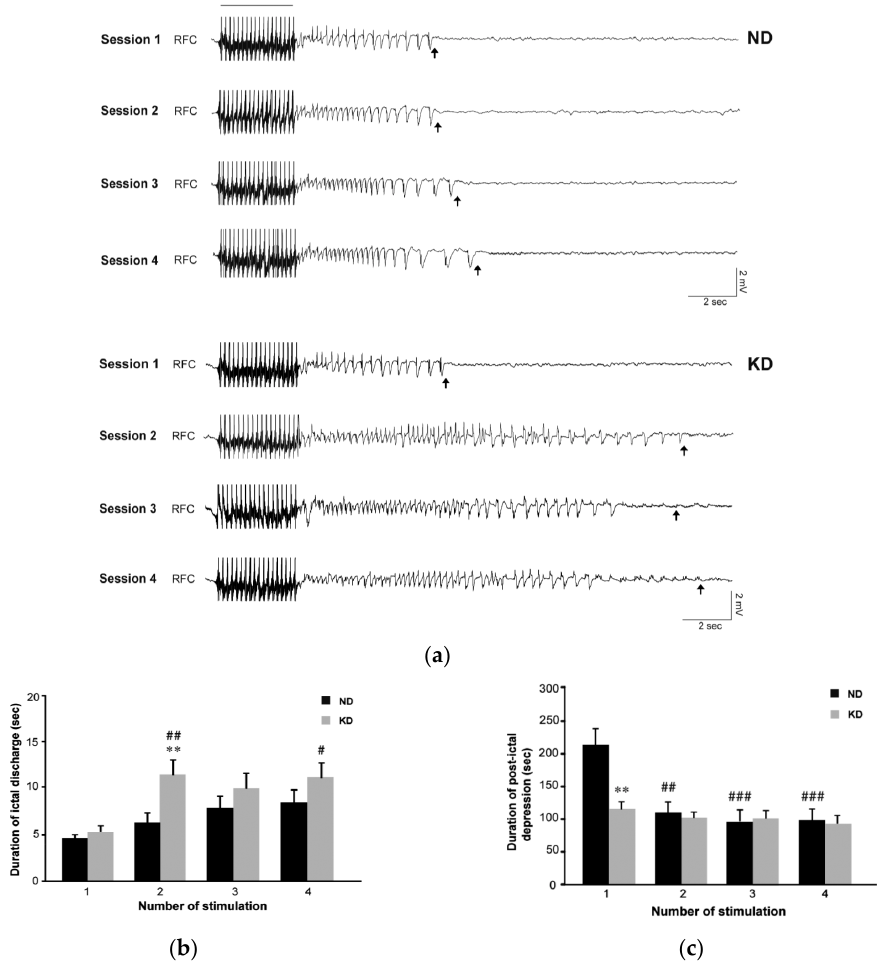
Figure 2. Video electrocorticographic (ECoG) recordings in mice fed the ketogenic diet (KD) and repeatedly tested in the 6-Hz corneal stimulation model. ( a ) ECoG traces illustrating the response detected in the presence of the normal diet (ND) or the KD, during and after a corneal stimulation of one representative mouse after repeated electrostimulations. The black bar indicates a stimulus artifact. Black arrows indicate the end of the ictal discharge. Note that the epileptiform activity changed in terms of duration and waveform when comparing session 1 with session 2. ( b ) Histograms illustrating the mean duration of ictal discharges recorded in session 1 and 2 in ND ( n = 9) and KD ( n = 9) groups. The duration of ictal discharges significantly increased in KD mice at the second session of stimulation (## p < 0.01 for session 2 vs. session 1; Holm–Šídák test). Moreover, these values were significantly higher than in ND mice when considering session 2 (** p < 0.01). Interestingly, a longer ictal activity was observed in the KD group in the subsequent sessions of seizure induction. In particular, a statistical difference was found by comparing session 4 to session 1 in the same animals (# p < 0.05; Holm–Šídák test). ( c ) Histograms illustrating the mean duration of post-ictal depression as measured in the various sessions of 6-Hz corneal stimulation. The duration of post-ictal depression was significantly reduced in the ND group at the second session of stimulation (## p < 0.01, sessions 2 vs. session 1). Note also that at the first session, post-ictal depression was shorter in KD mice compared to ND mice (** p < 0.01). RFC denotes right frontal cortex (epidural electrode). Statistical significance values are indicated as #: p < 0.05, **: p < 0.01, ##: p < 0.01, ###: p < 0.001.